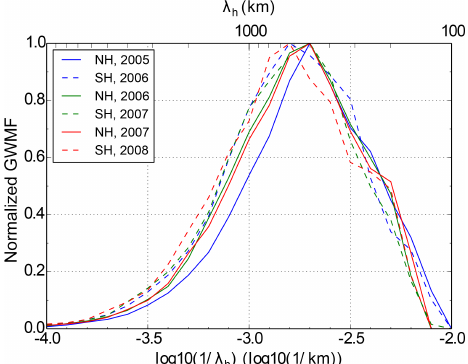
Figure A2. Observed normalized GWMF spectra at vertical wave- length λ z = 9km for different hemispheres for 3 consecutive years. Solid blue, green, red lines show spectra averaged for boreal sum- mer (June–August) for 2005, 2006, 2007 respectively. Dashed blue, green, red lines show spectra averaged for austral summer (December–February) for 2005/6, 2006/7, 2007/8.